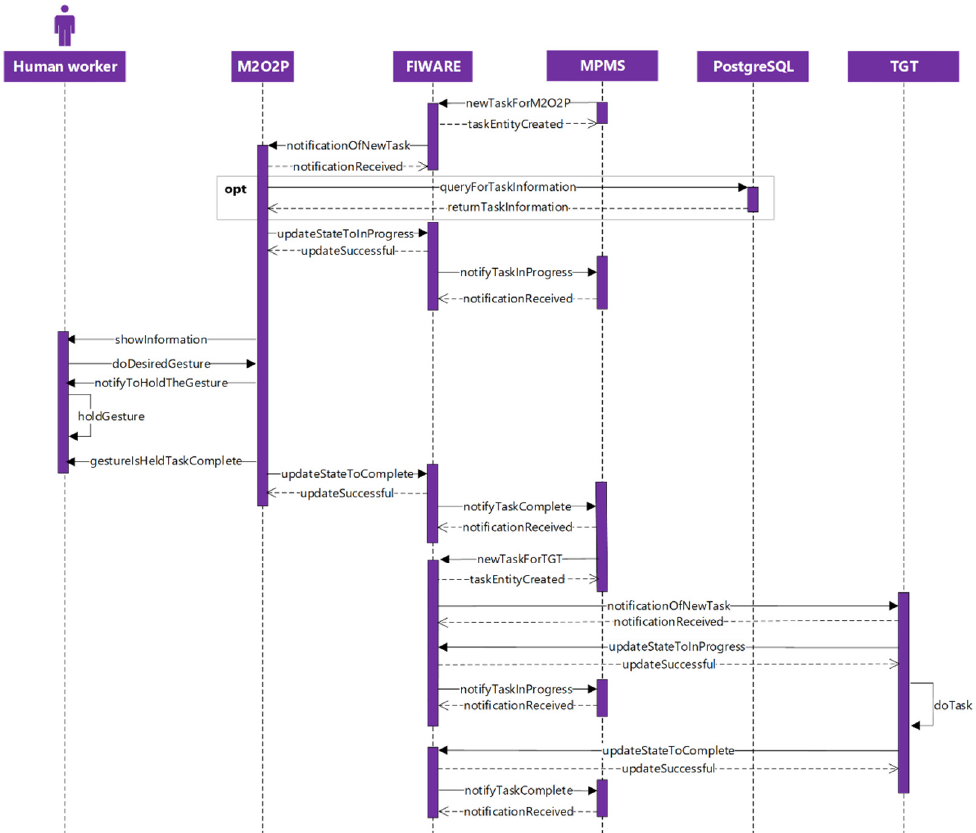
Figure 10. Sequence diagram of receiving and completing the task. Each local level component communicates with the MPMS through FIWARE, by receiving task, setting the state of the task to inProgress , and, ultimately, to completed when the task is ready.